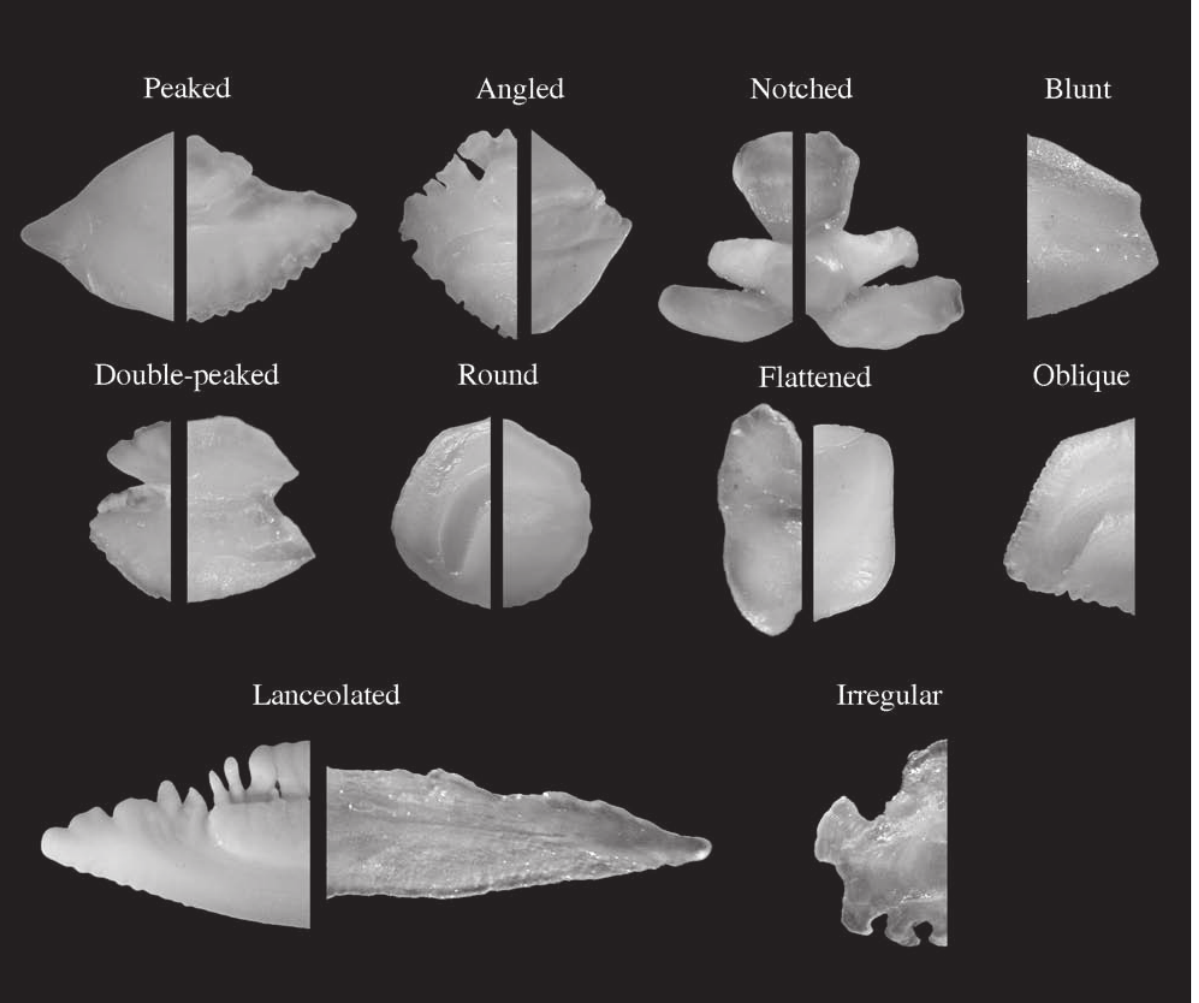
Fig. 8. – Terms used to describe the types of anterior and posterior otolith